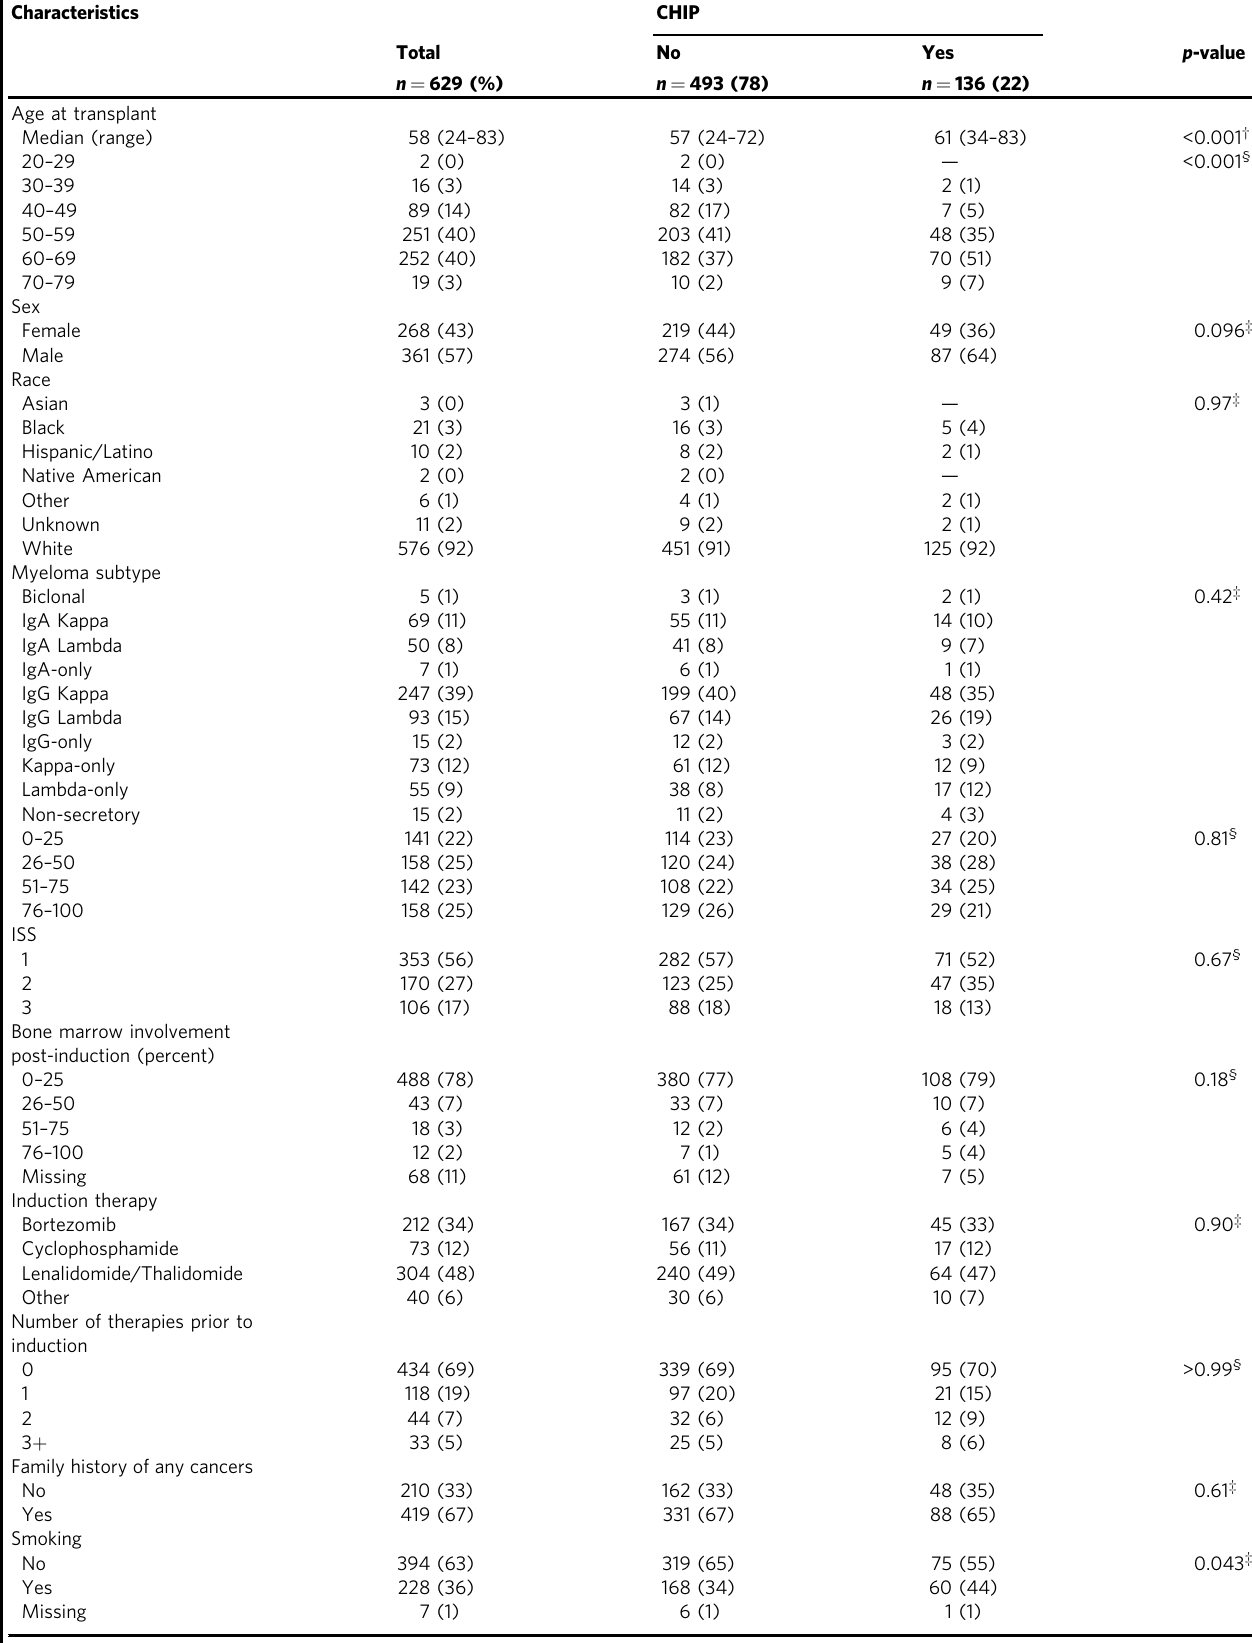
Table 1 Patient